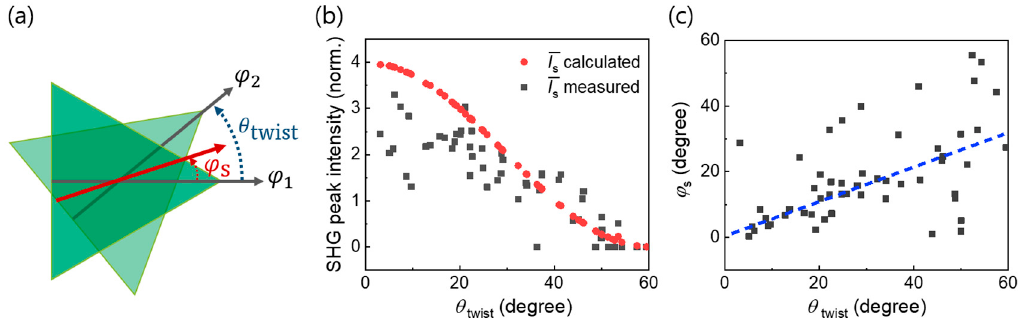
Figure 3. ( a ) Illustration of the angle of the twisted bilayer of MoS 2 flakes. φ 1 and φ 2 indicate the armchair directions of the MoS 2 flakes, while φ s indicates the peak angle of the SHG emission. The twist angle is defined by θ twist = φ 1 − φ 2 ; ( b ) normalized SHG peak intensity for the twisted bilayer MoS 2 as a function of θ twist (black squares). The red circles indicate the calculated SHG peak intensities derived from the polarization interference model; ( c ) SHG peak angle ( φ s ) at the twisted region as a function of θ twist . The dashed line corresponds to the line of φ s = θ twist /2.